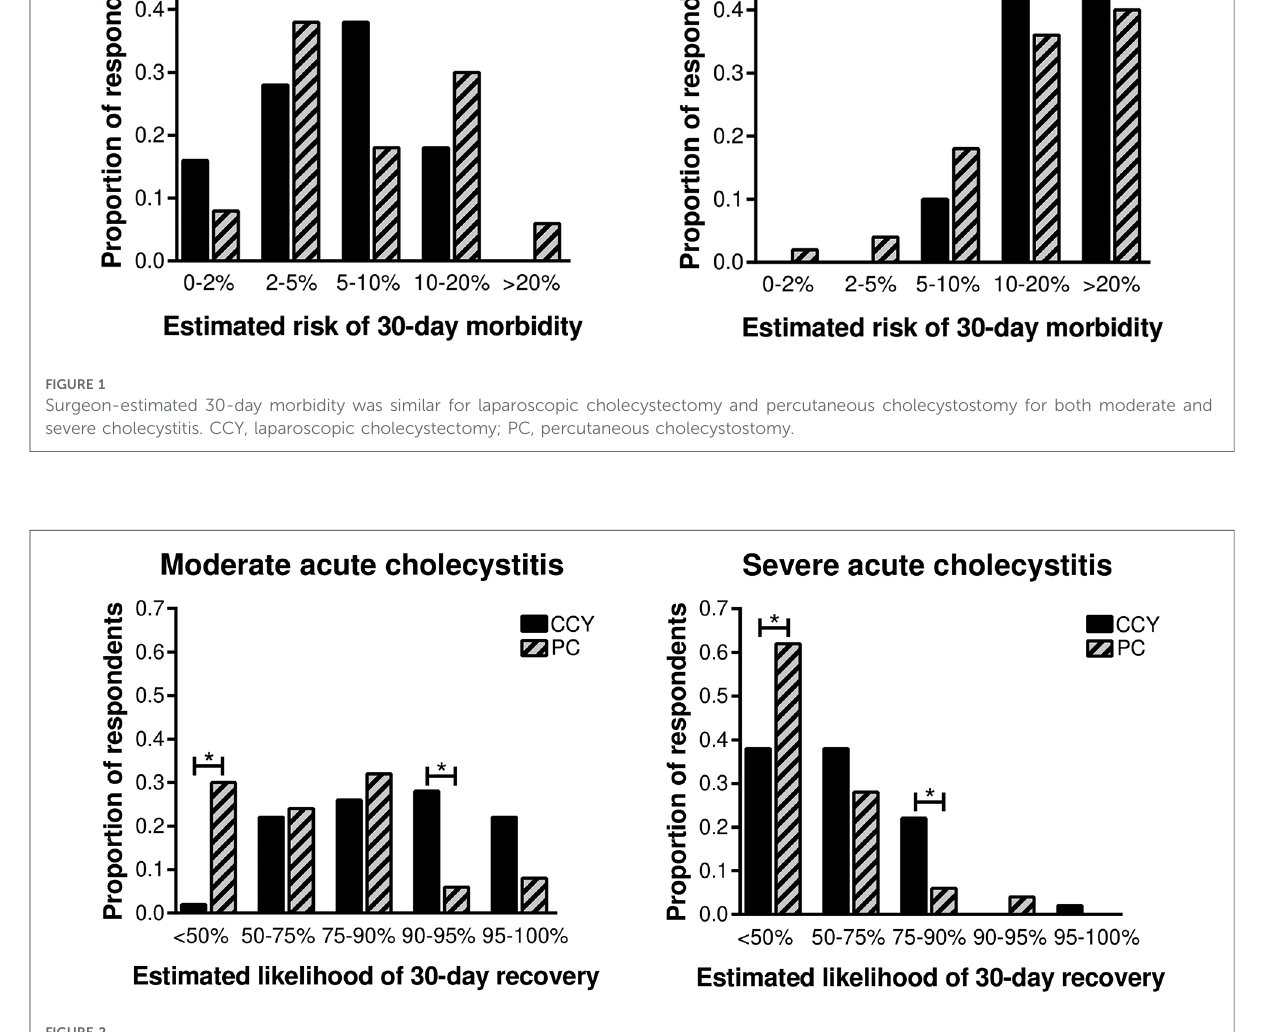
FIGURE 2 Surgeon-estimated 30-day recovery favored laparoscopic cholecystectomy over percutaneous cholecystectomy for both moderate and severe cholecystitis. CCY, laparoscopic cholecystectomy; PC, percutaneous cholecystostomy. * p <0.05 between